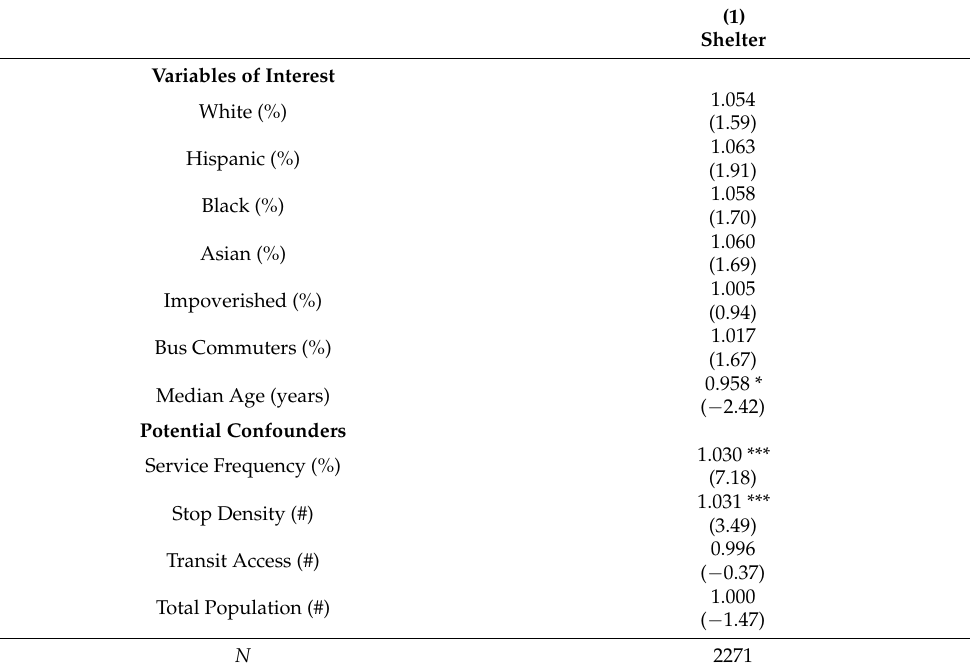
Table 3. Model output for relations between sociodemographic characteristics and bus stop shelters.